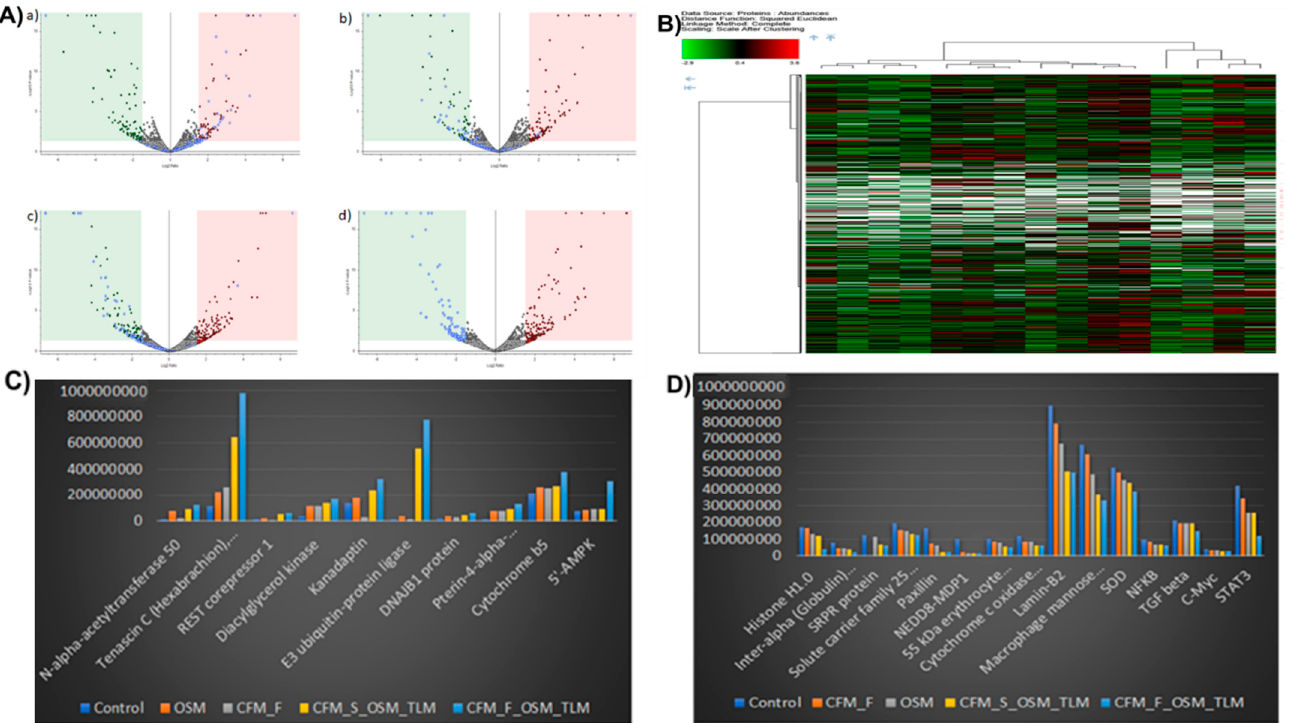
Figure 3. Proteomic identified differentially expressed proteins (DEPs) in lung cancer after treatment. ( A ) Representative Volcano plots of DEPs in between (a) Control and Osimertinib (OSM) groups, (b) Control and CFM4.17 nanolipid formulation (CFM-F), (c) Control and CFM-F_OSM_ telmisartan (TLM) combination, and (d) Control and CFM4.17 solution (CFM-S) OSM_TLM combination ( B ) Representing illustrations of hierarchical clustering analysis of differentially expressed proteins in control and treatment groups and proteins with the highest abundance alterations. ( C ) Schematic representation showing proteins with the largest overall increase in expression and ( D ) the proteins with the greatest reduction in expression upon treatment are represented.